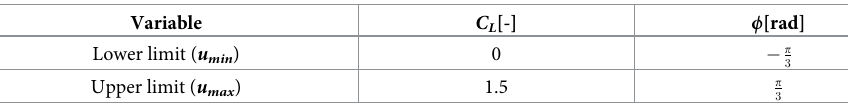
Table 2. Acceptable range of the control variables.